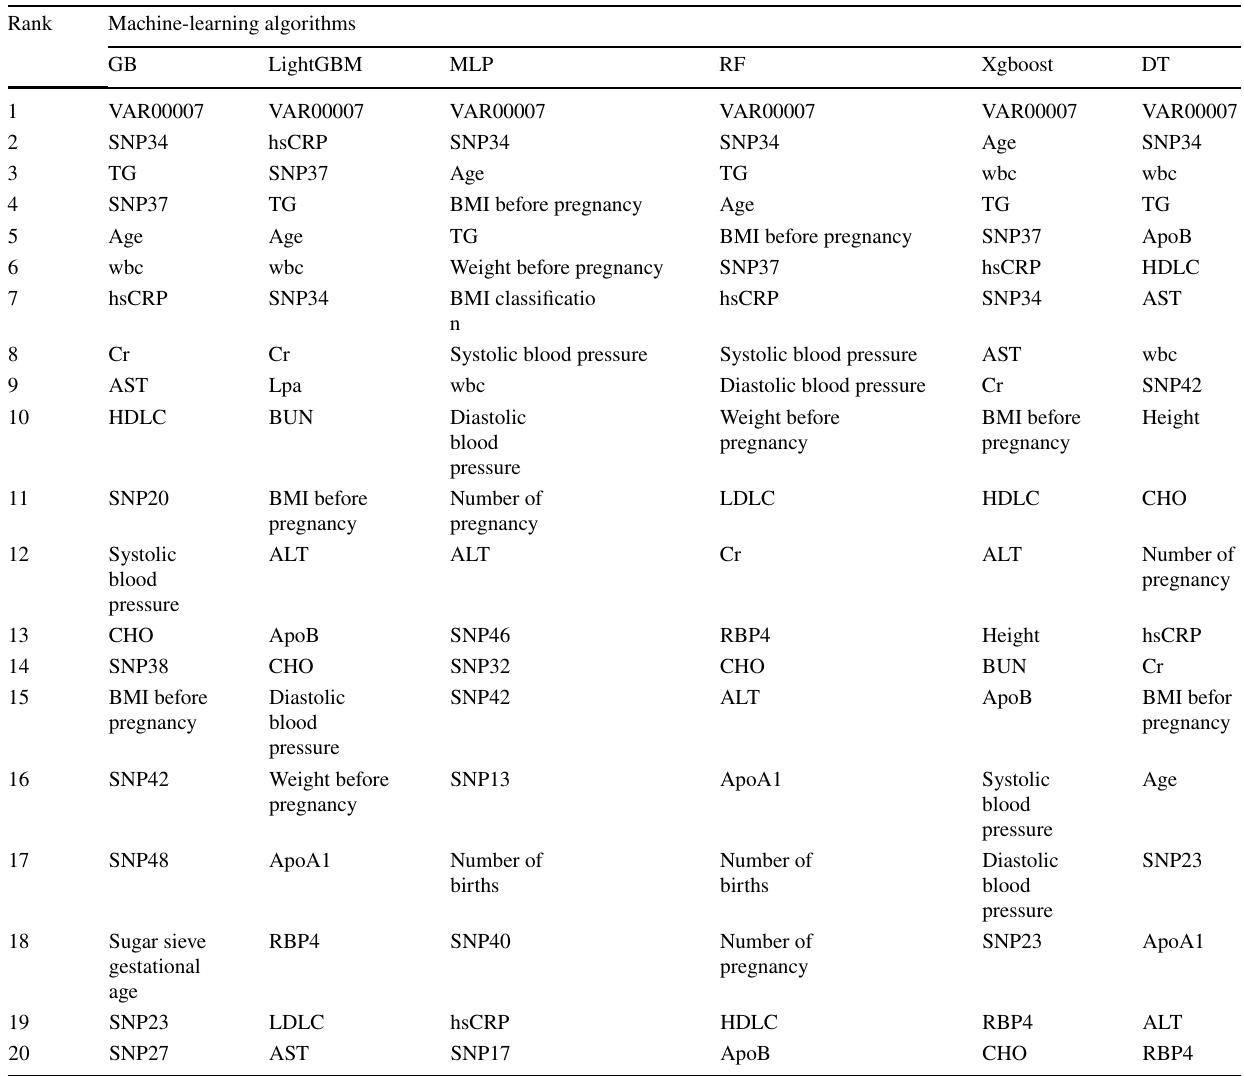
Table 3 The top 20 ranked variables for each algorithm Rank Machine-learning